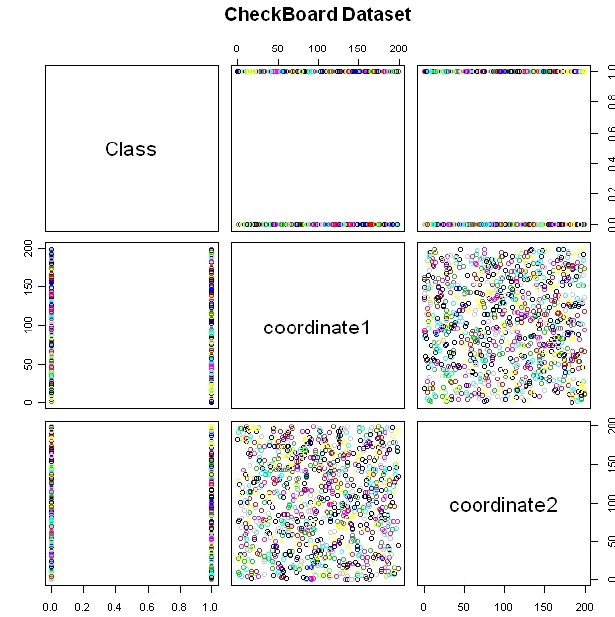
Fig. 13. 178 Wine Data.